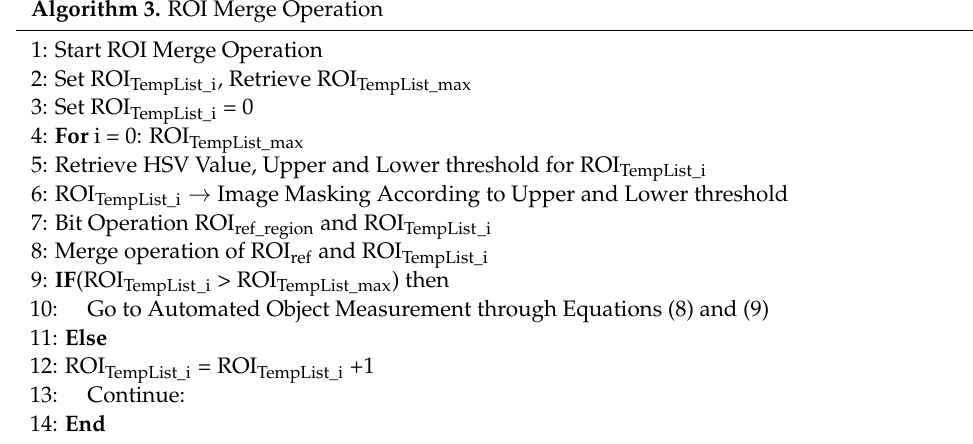
Algorithm 3. ROI Merge